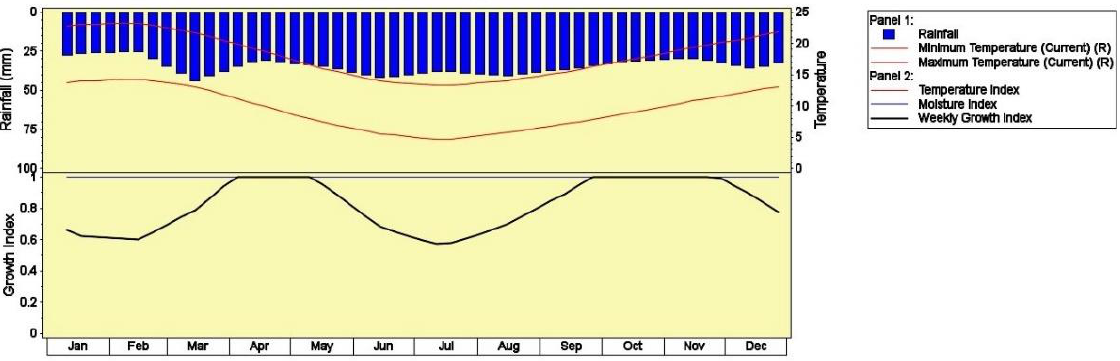
Figure 5. Weekly growth index and climate variables at Te Puke, Bay of Plenty, New Zealand for Psa produced by CLIMEX model.